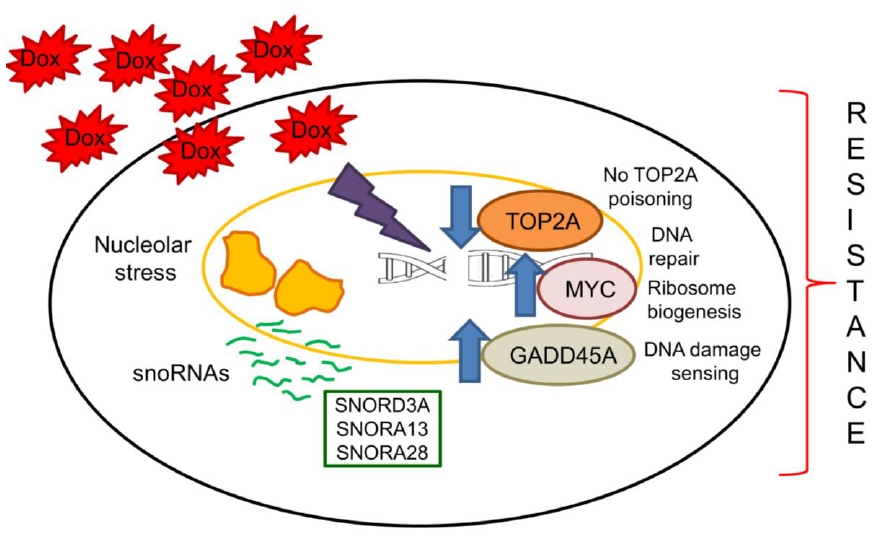
Figure 6. Linkage between snoRNAs and acquisition of resistance to doxorubicin. The exposure to Dox induces a continuous nucleolar stress that up-regulates several snoRNAs, including SNORD3A , SNORA13 and SNORA28 . Their increase mediates resistance to Dox by down-regulating TOP2A , the main target of Dox, and by up-regulating GADD45A , a DNA damaging sensor that promotes the adaptation to chronic stresses, and MYC , a strong oncogenic factor inducing DNA repair genes and ribosomal protein synthesis. Arrow: decrease or increase, respectively.